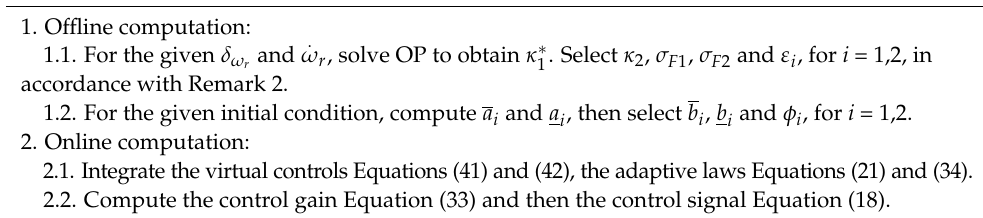
Algorithm 1 Proposed controller design